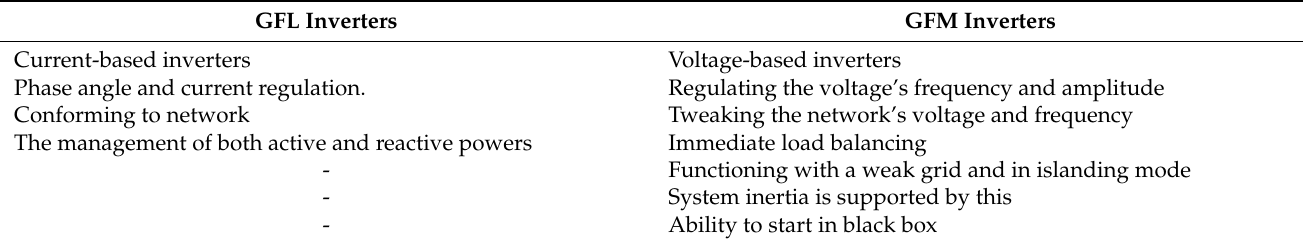
Table 2. The capabilities of GFL versus GFM